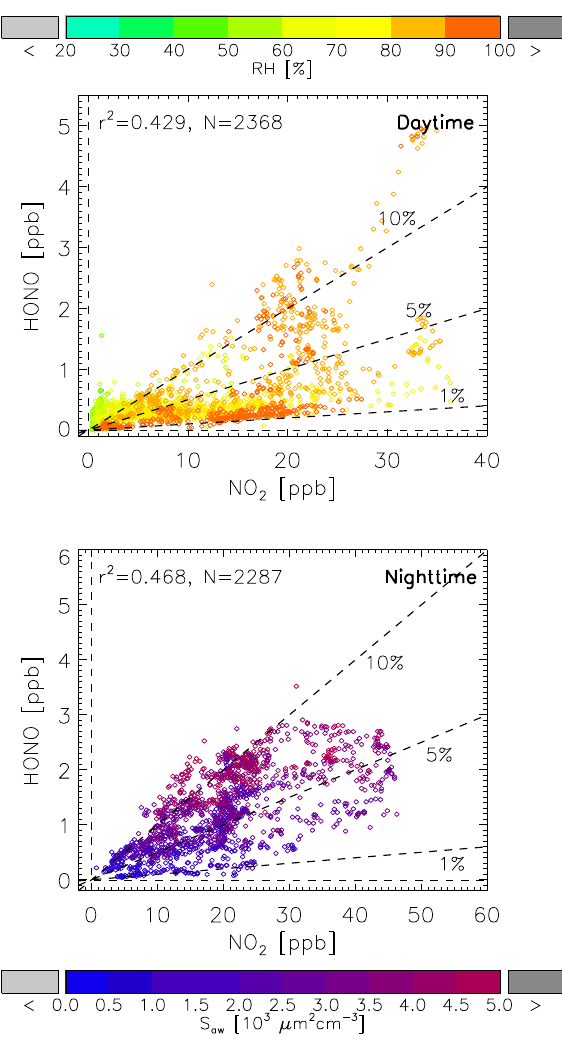
Fig. 4. Correlation between HONO and NO 2 . The dashed lines correspond to the HONO / NO 2 ratio of 10%, 5% and 1%. The nighttime data are in the time period of 19:00–06:00LT and color coded by the aerosol surface density; while the daytime data are color coded by the relative